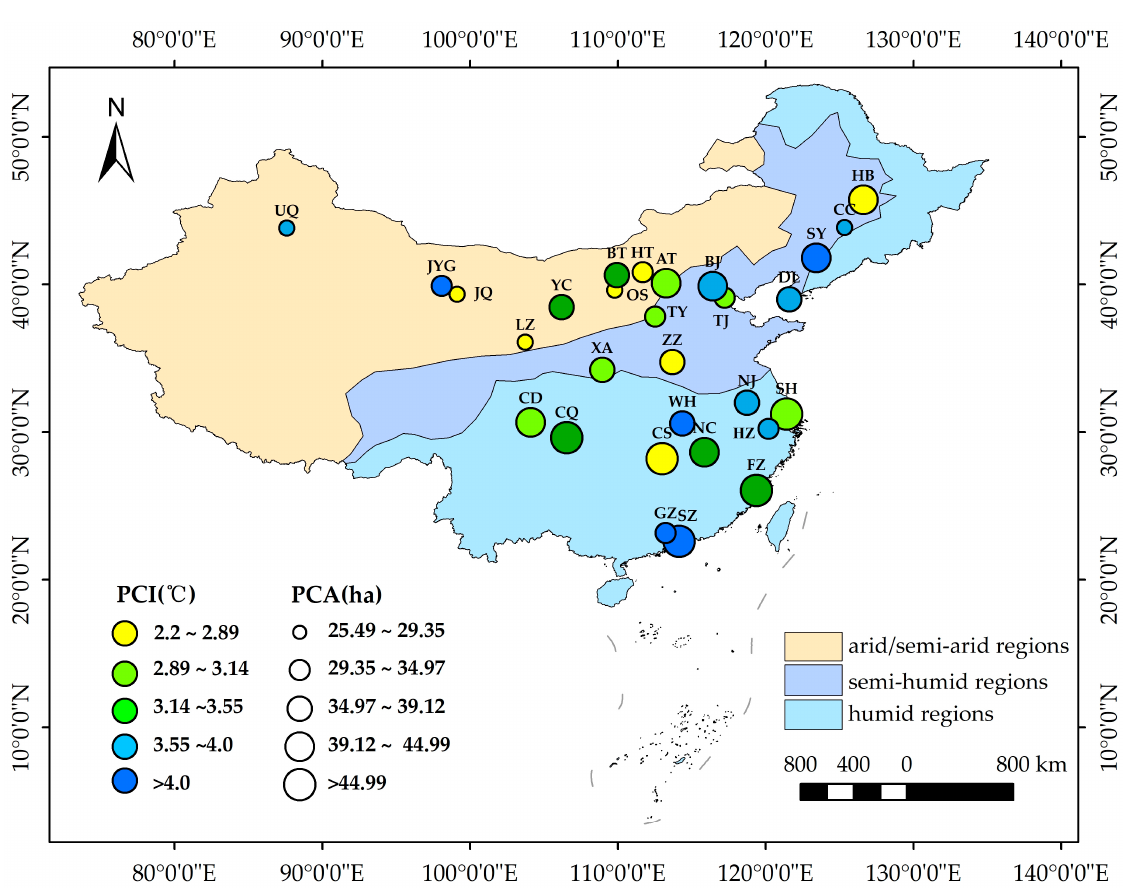
Figure 5. The national spatial pattern differences of the cooling effect.